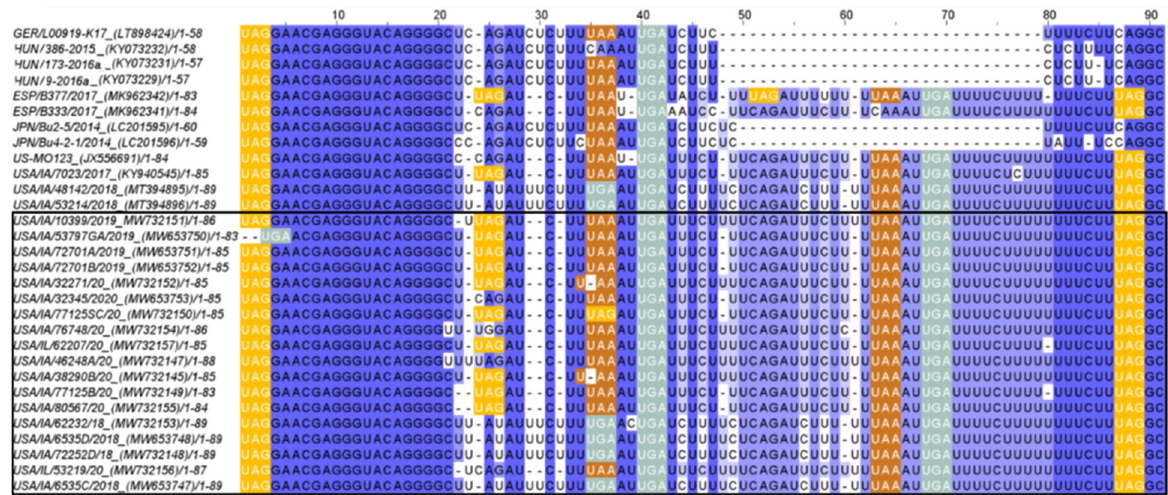
Figure 4. Sequence alignment of the 3 ′ UTR region of PoAstV3 strains. Sequences with an incomplete 3 ′ UTR region were omitted. Note insertion-deletion (IN/DEL) region present between bases 48–79 in USA and Spanish sequences and absent in Hungarian and Japanese strains, and GER/L00919-K17/2014. Stop codons UAG, UAA and UGA, in amber, ochre, and opal boxes, respectively. Dark blue indicates higher sequence percent identity. Poly (a) tail regions were excluded. Sequences were aligned using ClustalO webserver under default settings. Sequences identified in this study are denoted by a black box.